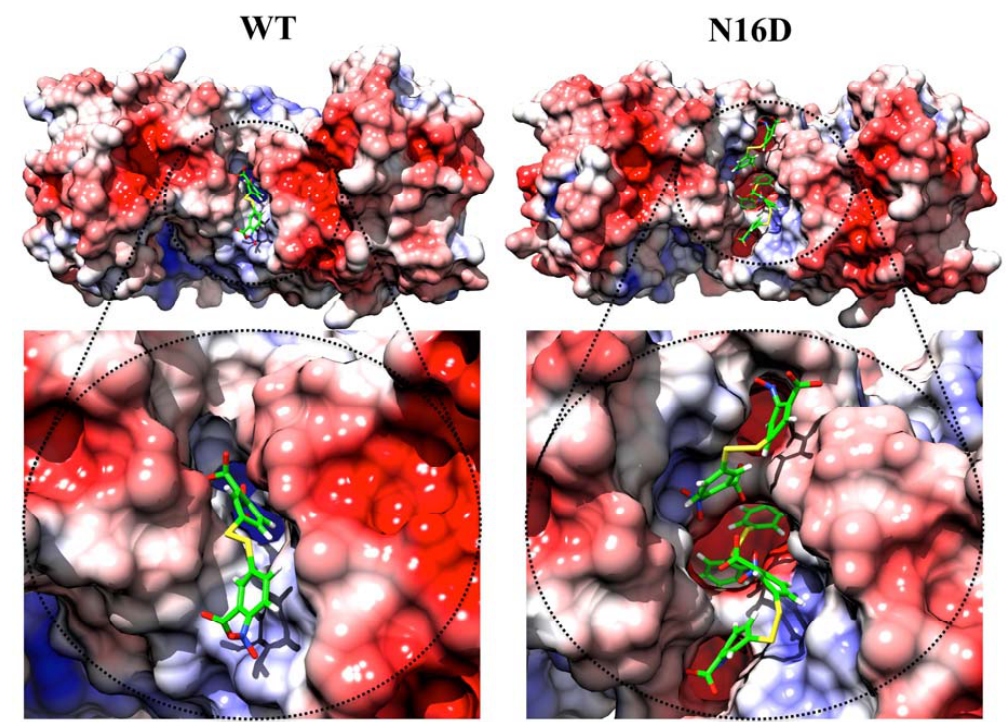
Figure 3. Docking of 5,5 ′‐ dithiobis ‐ (2 ‐ nitrobenzoic acid) (DTNB) and electrostatic potential surface of the WT and N16D HsTIM structures. The figures are an ensemble of docking and the electrostatic potential surface results. As seen in WT HsTIM, DTNB was incorporated superficially in the interface of this structure, while in N16D HsTIM, three DTNB molecules were docked in the same region. Moreover, one DTNB was successfully docked in the innermost zone of the interface in N16D HsTIM. As seen in the electrostatic potential near the DTNB in WT or N16D HsTIM, positive charges are confirmed. However, in the innermost zone of the interface in N16D HsTIM, the negative charges conform. Color codes represent the electrostatic potential surface energy values of − 5.0 ( ) and + 5.0 ( ). Figures were modeled with the molecular graphics images produced with the UCSF Chimera package [18].